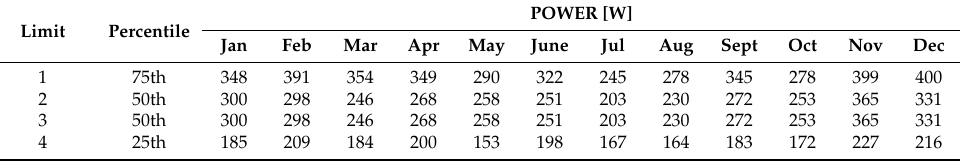
Table A7. Power thresholds limit for calculations over the non-working